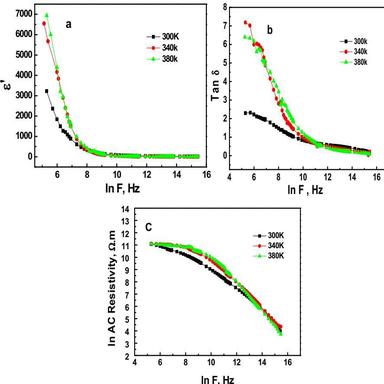
Dielectric permittivity (ε′ ) (a), Dissipation factor (Tan δ) (b), and AC resistivity (c) with frequency at different temperatures for GO@TiO2.ZnO.Ag.